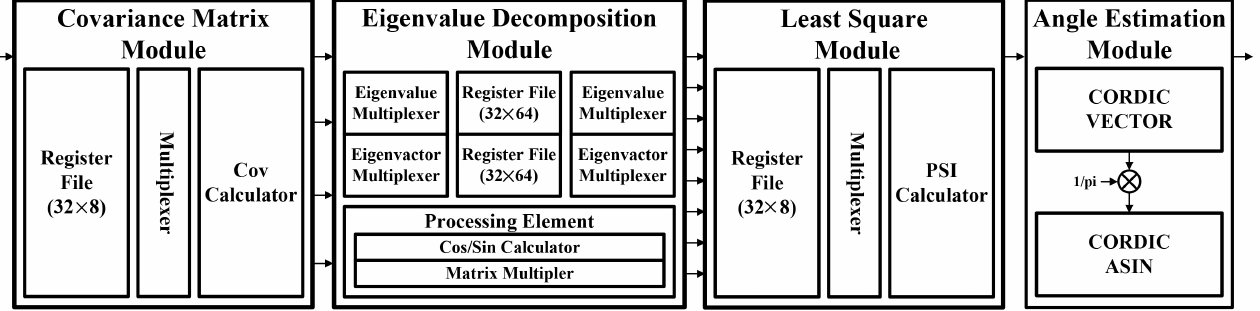
Figure 6. Hardware architecture of proposed ESPRIT